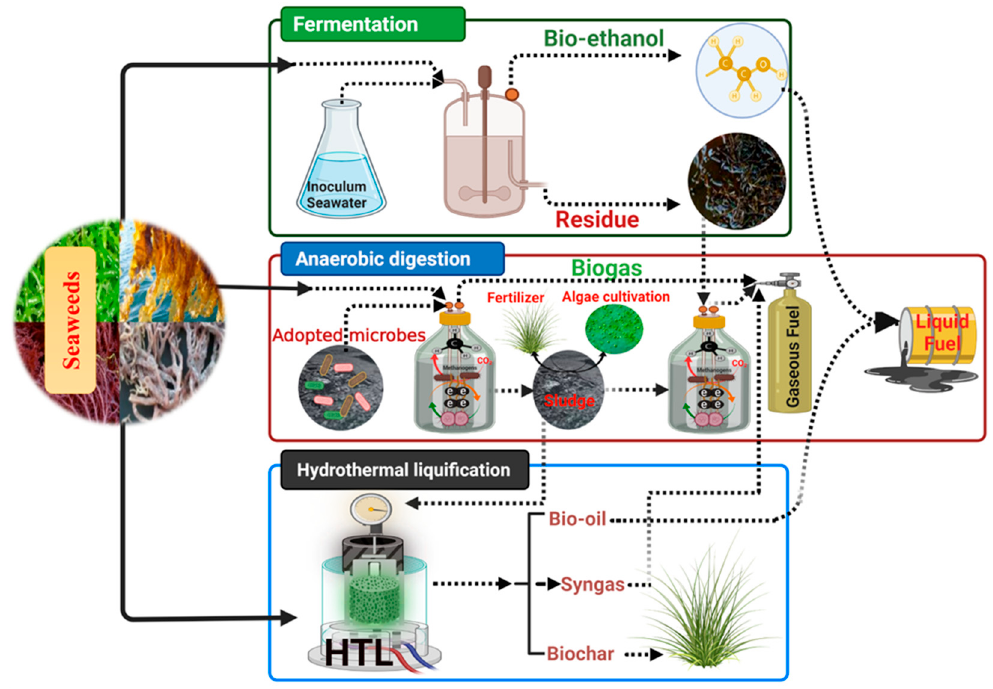
Figure 4. Different routes of biofuel production from seaweed for enhanced energy recovery and zero-waste approach.